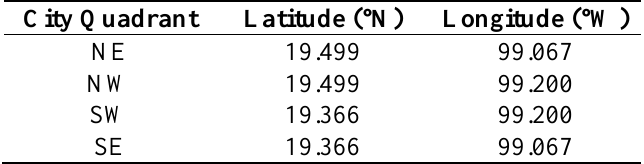
Table 1. Geographical positions of the centers of the Mexico City quadrants.